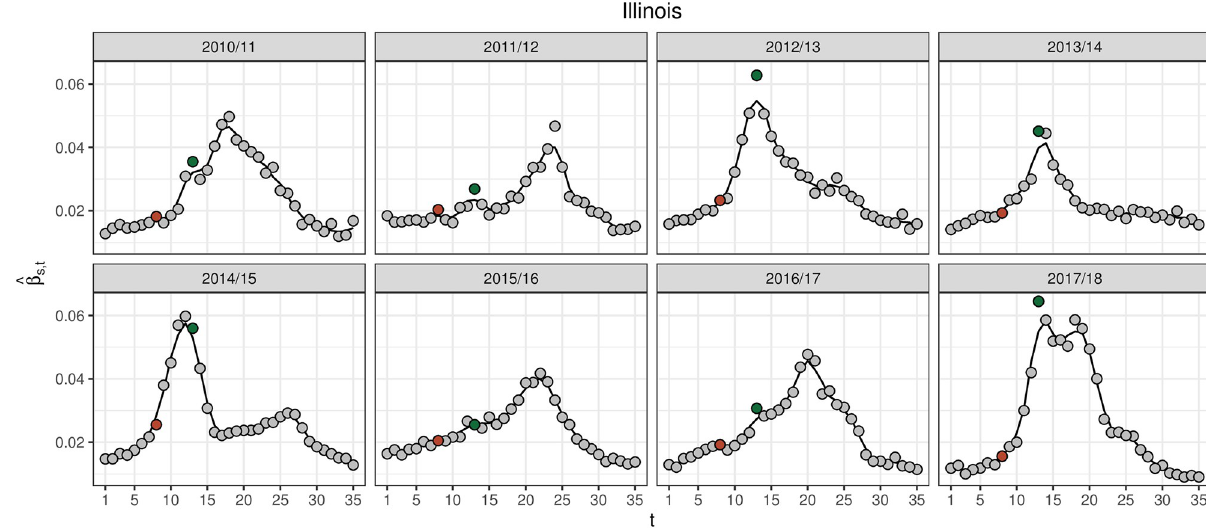
Fig 1. y s , t (grey points) and ^ b (black line) for the historical seasons for Illinois. y s , t for the week of Thanksgiving ( t = 8) and Christmas ( t = 13) are s ; t highlighted in brown and green, respectively. ^ b typically underestimates the sharp uptick in y s , t observed on Christmas and to a lesser extent s ; t Thanksgiving, which is likely a result of changes in reporting and care-seeking behavior over the holidays.